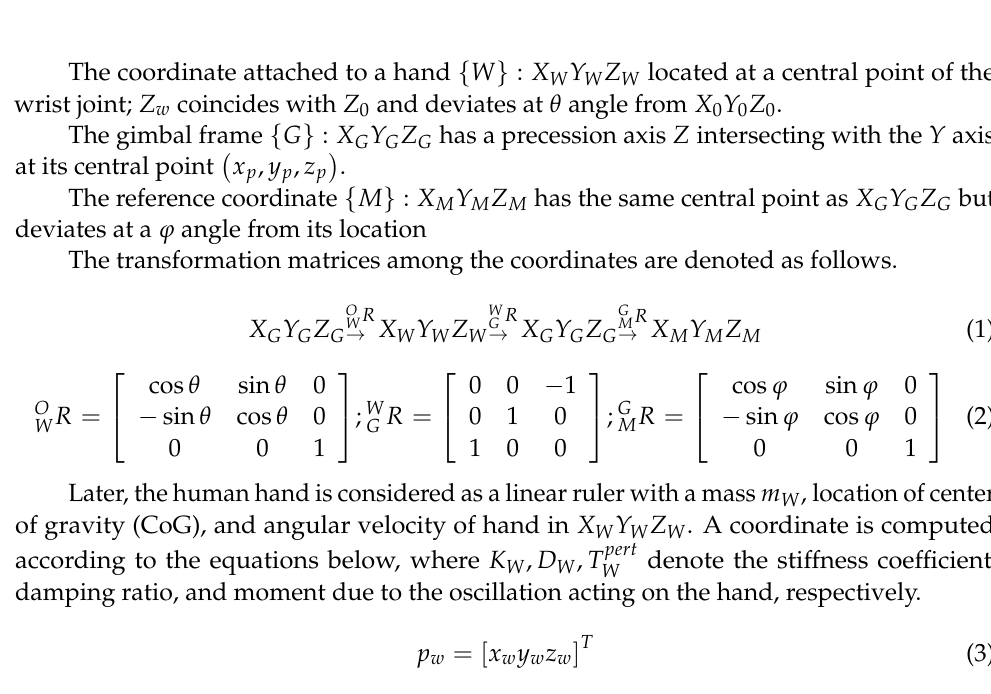
The linear velocity of the human hand model can be estimated as in Figure 4.